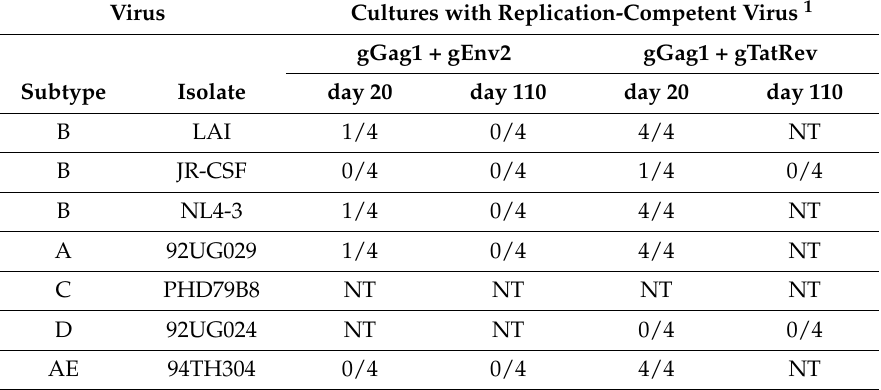
Table 1. Virus rescue